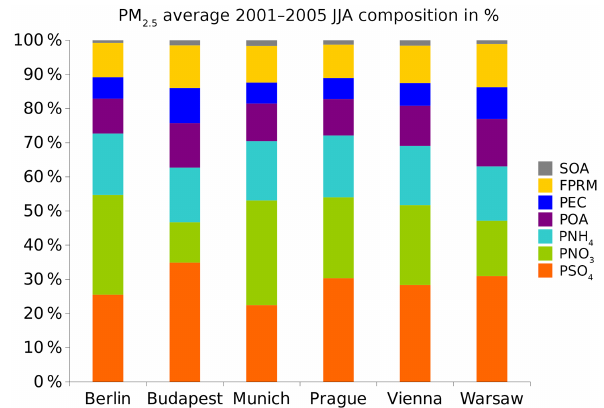
Figure 6. Average percentual composition of urban 2001-2005 JJA average PM 2 . 5 aerosol for selected cities: PSO 4 – sulfates, PNO 3 – nitrates, PNH 4 – ammonium, POA – primary organic carbon, PEC – black carbon, FPRM – other fine particle matter, SOA – secondary organic aerosol